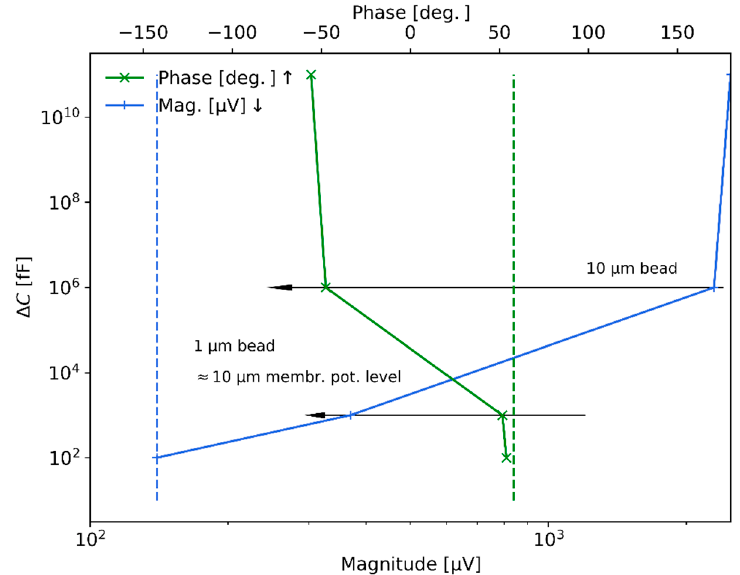
Figure 10. Electromagnetic measurement results for 1 μm and 10 μm polystyrene beads transformed into equivalent capacitance change. The blue and green solid lines represent the detected levels of voltage magnitude and phase, while the dashed lines represent the sensitivity limit of the system (magnitude and phase).